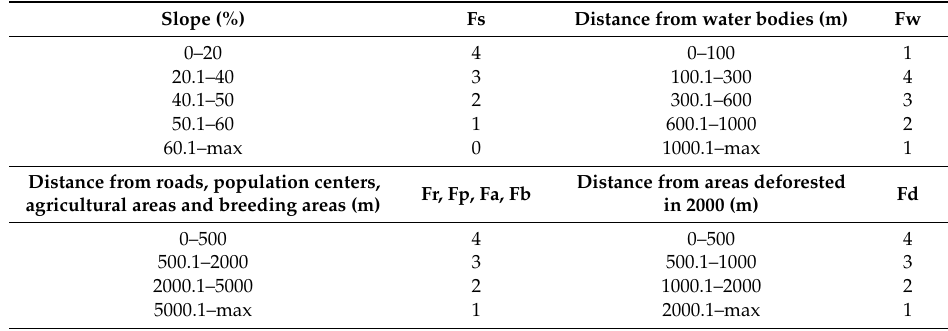
Table 2. Hazard values of slope factor (Fs), factor of proximity to water bodies (Fw), factor of proximity to roads (Fr), population centers (Fp), agricultural areas (Fa) and breeding areas (Fb) and factor of proximity to areas deforested in 2000 (Fd). The classification for Fr, Fo, Fa and Fb is the same.